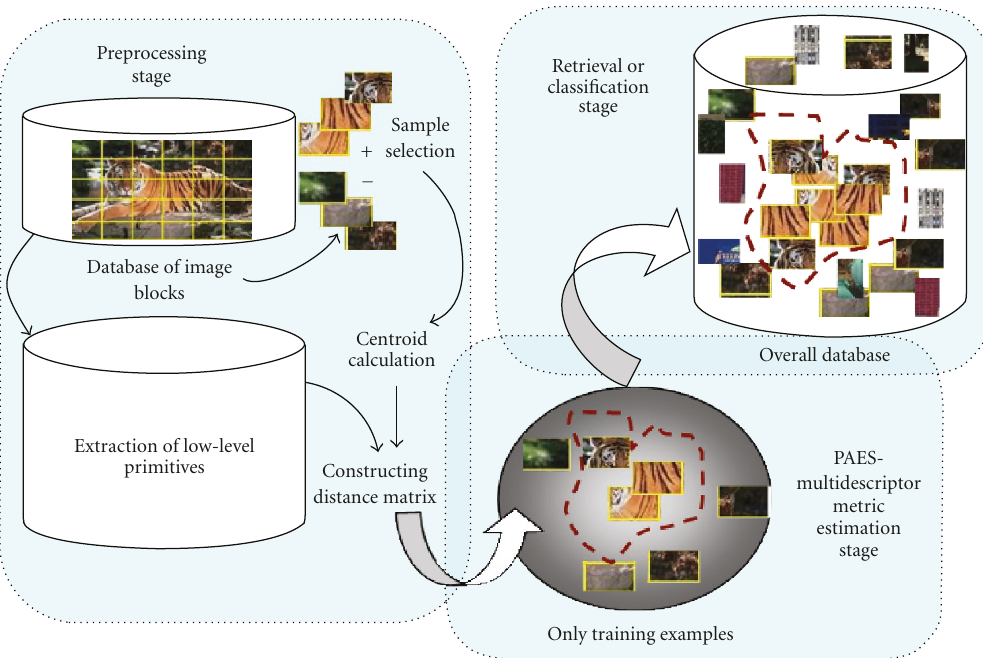
Figure 2: Framework